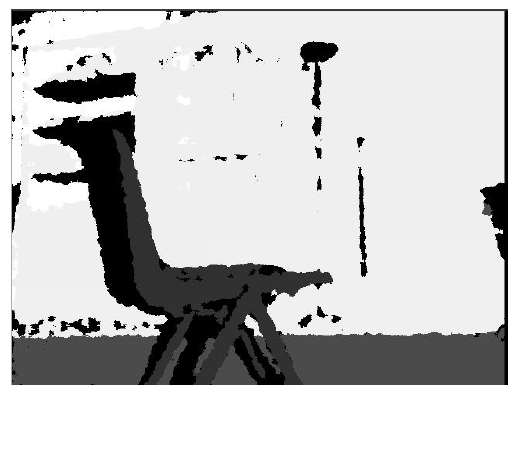
Figure 2. Depth image provided by the